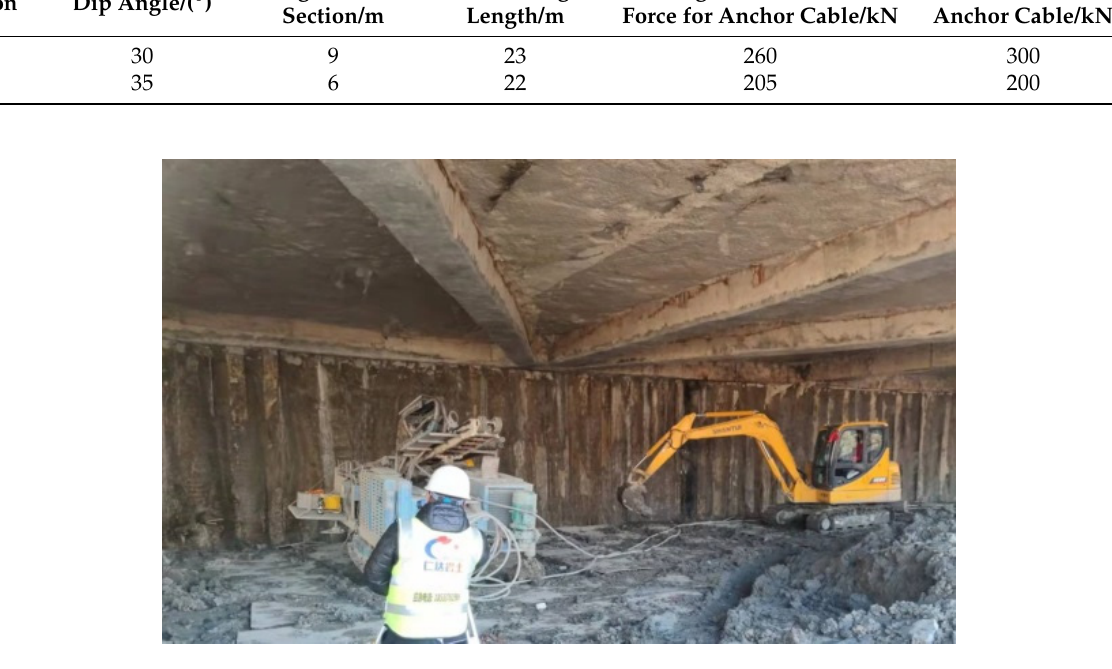
Figure 5. Drilling of the anchor cables.